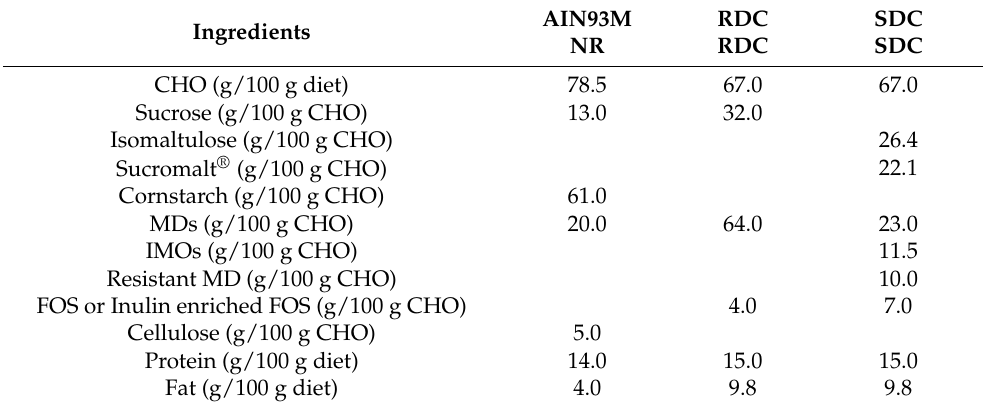
Table 1. Composition of control (NR) and experimental diets (RDC and